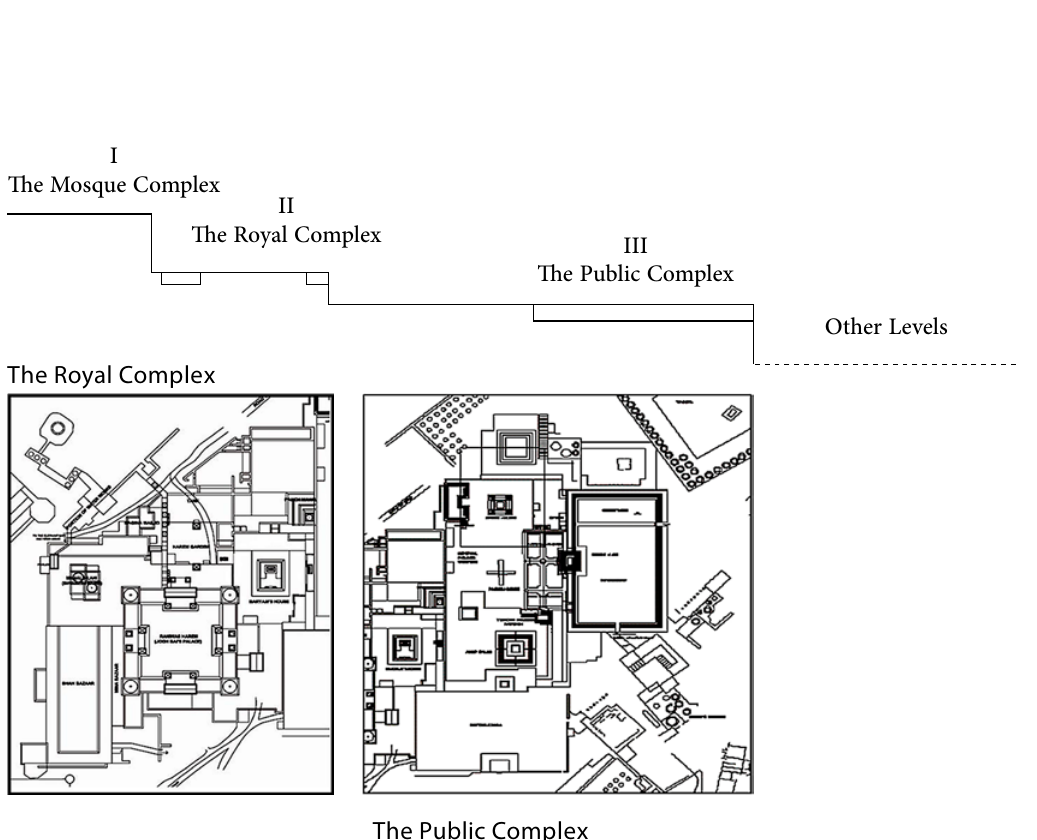
fig. 3b. The terraced layout and planning of fatehpur Sikri with its cloistered and overlapping spaces of the royal and Public Complex, with key buildings located at points of adjacency, centrality or intersection (according to Shaukat et al.